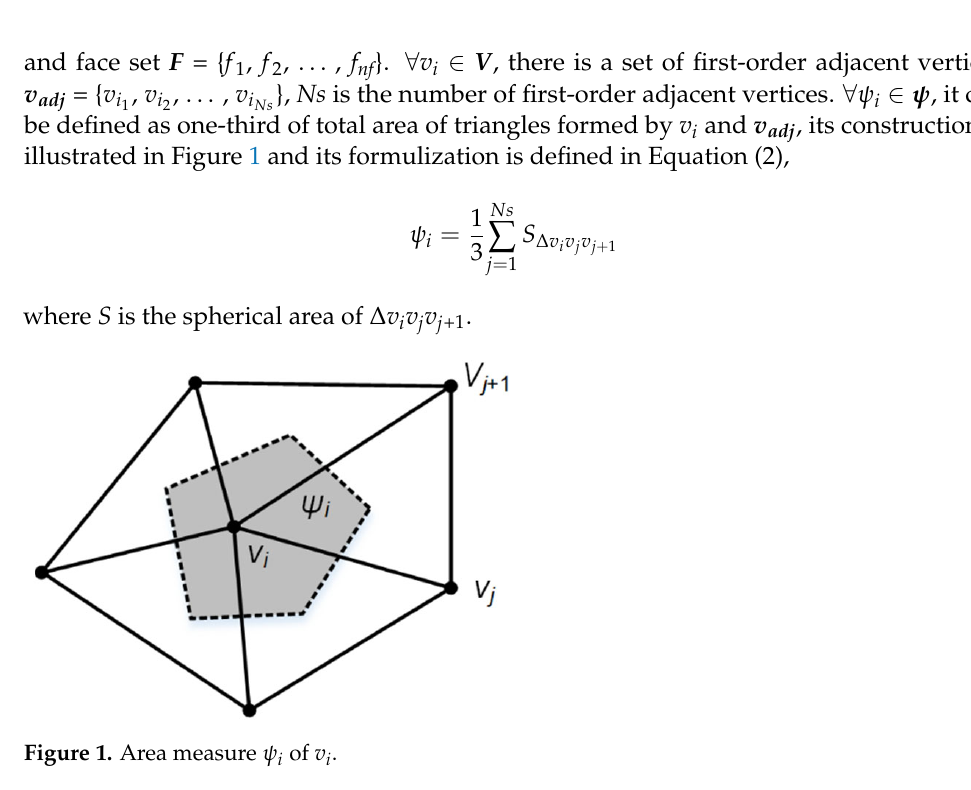
Figure 1. Area measure ψ i of v i . There is an optimal transportation mapping T : ( M , ψ ) → ( N , ϕ ), such that ϕ i = ψ i and C ( T ) in Equation (3) is minimal, in which N { V *, E , F } is the image of M , ϕ is a measure set of N .